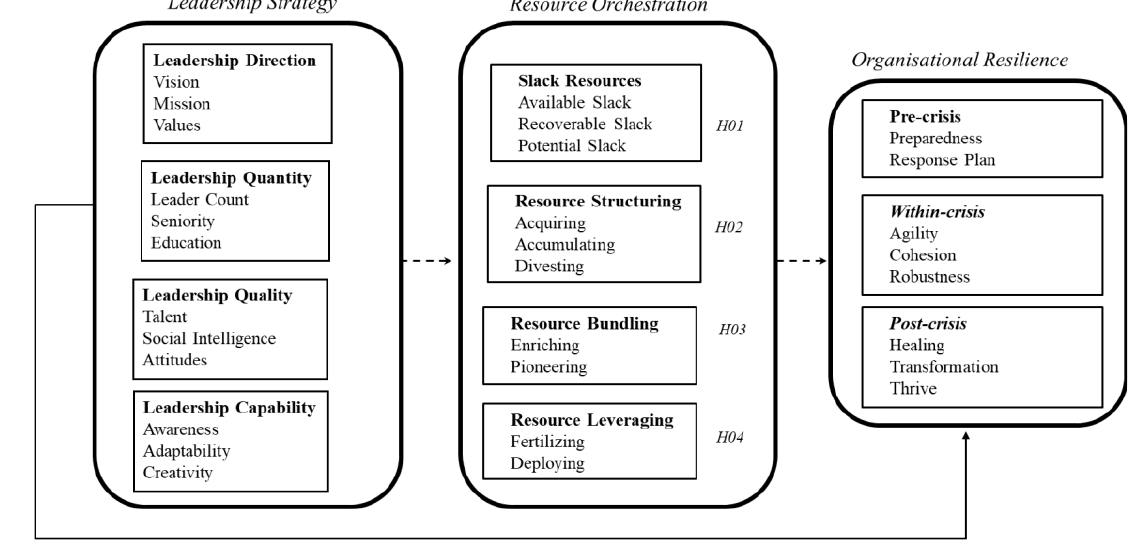
Figure 1: Conceptual